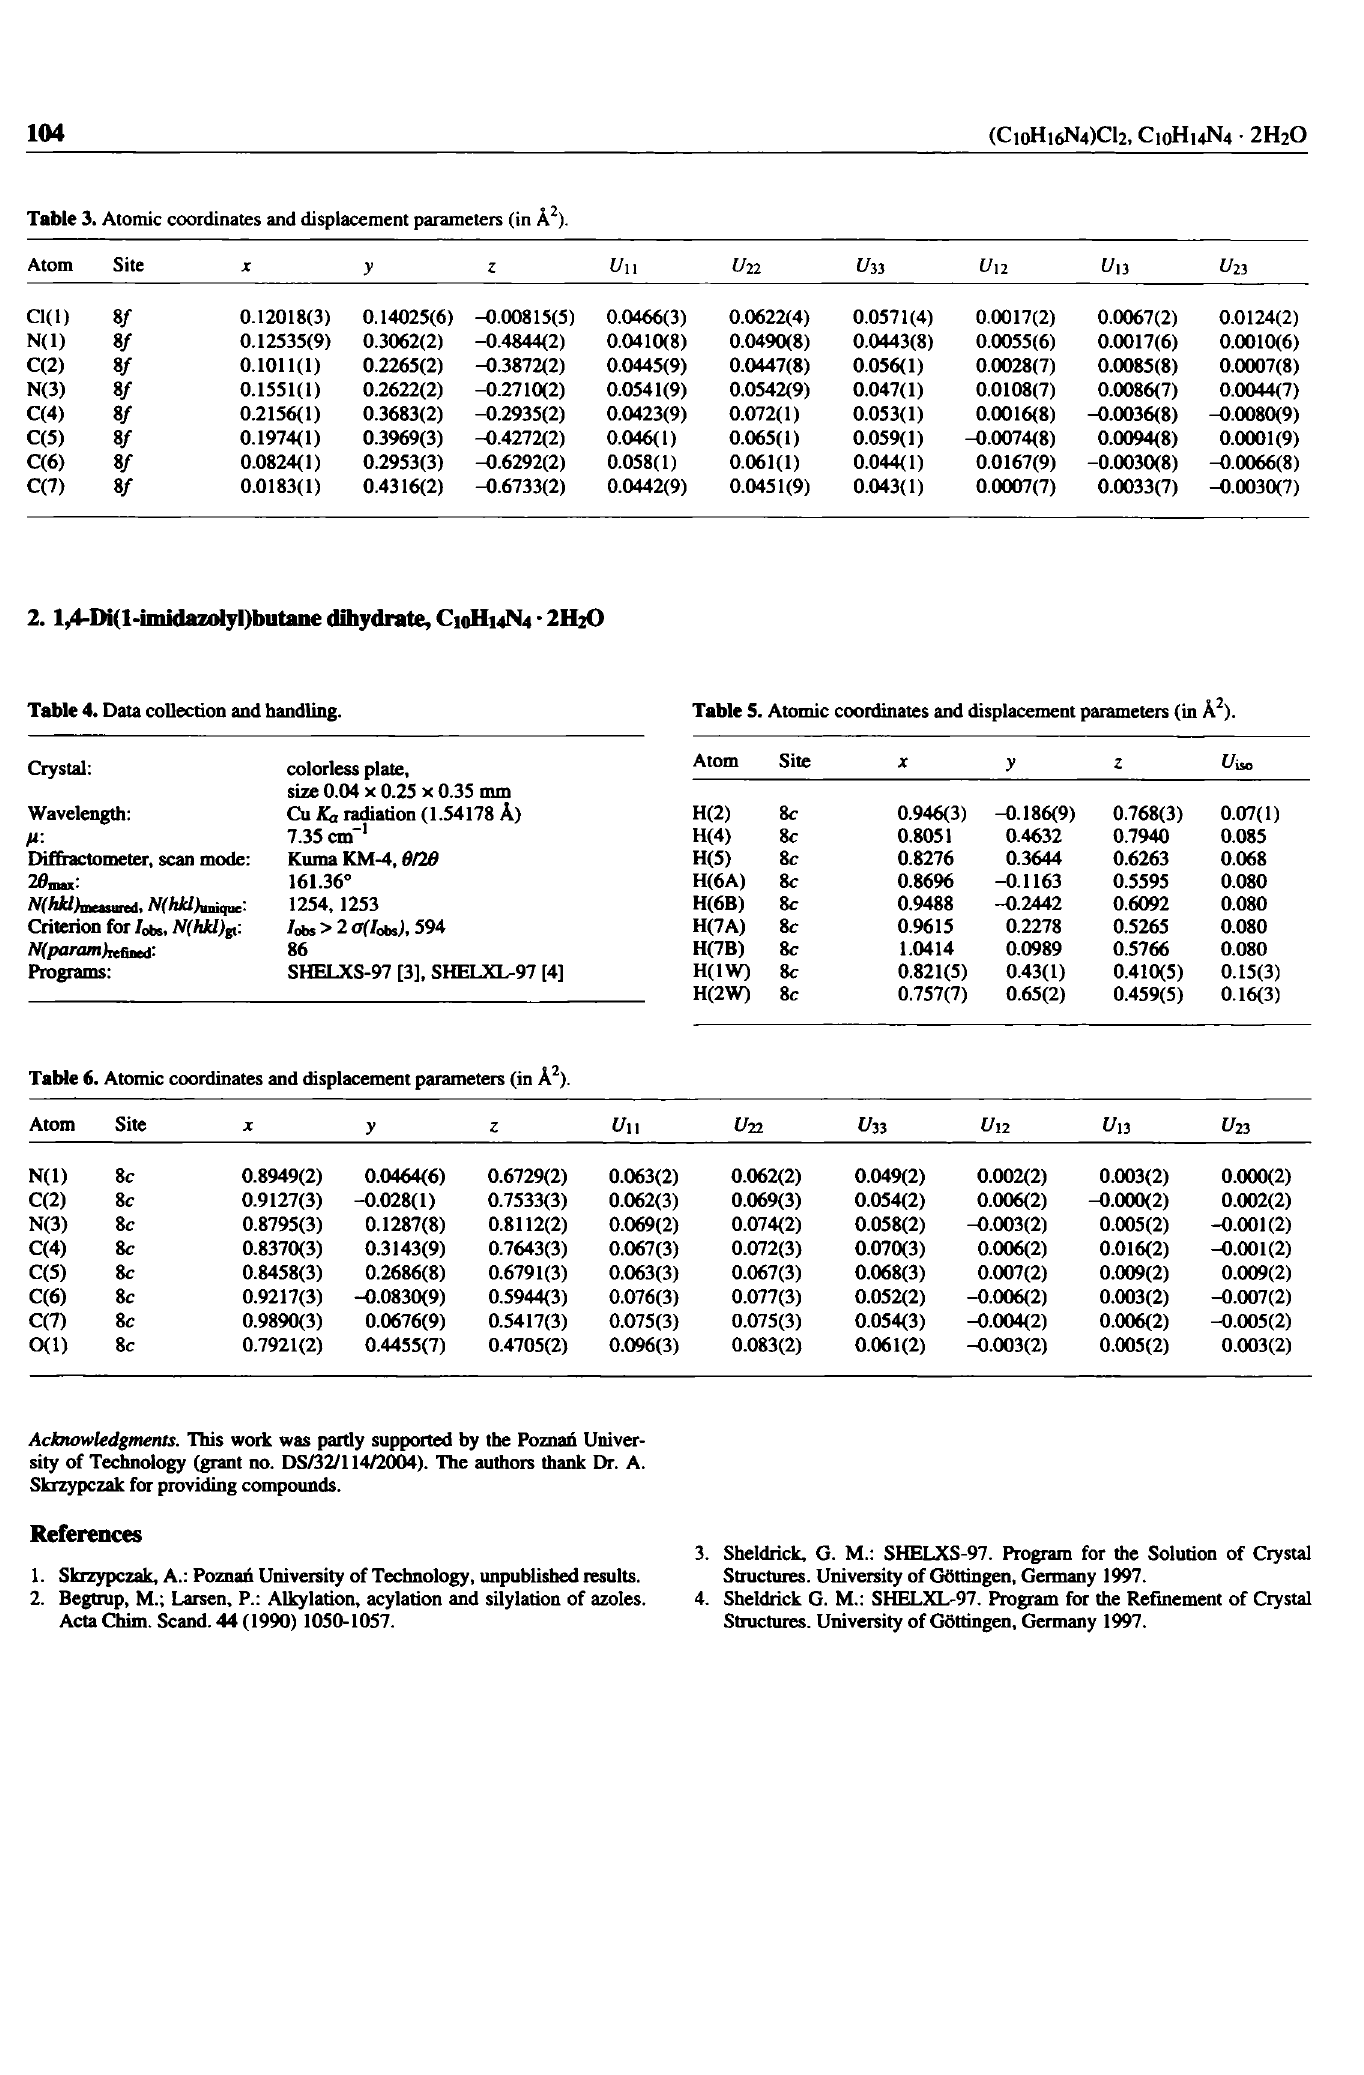
Table 4. Data collection and handling. Table 5. Atomic coordinates and displacement parameters (in λ 2 ).